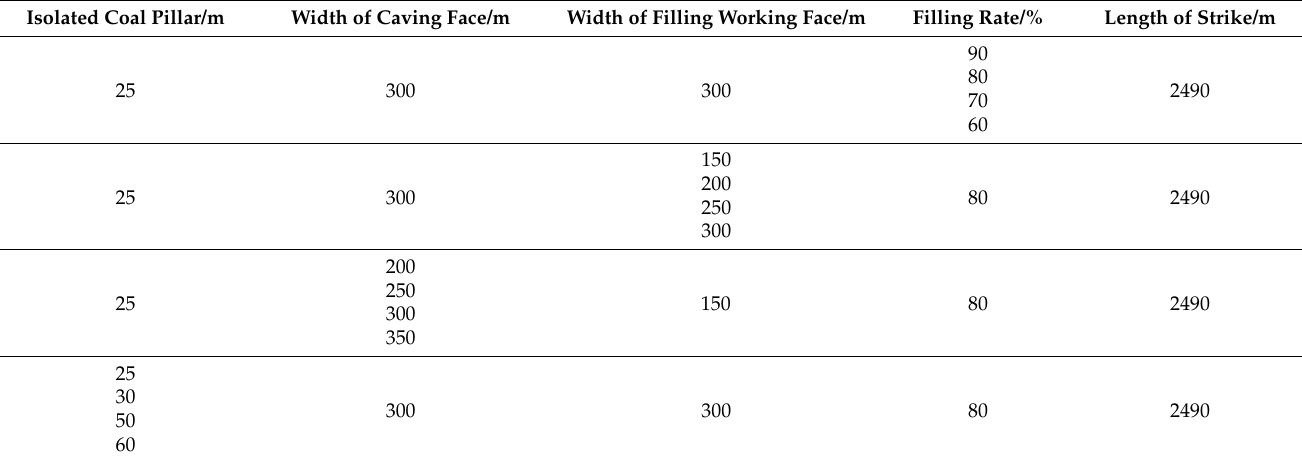
Table 6. Study scheme of the effect of filling ratio on surface subsidence and energy polling.